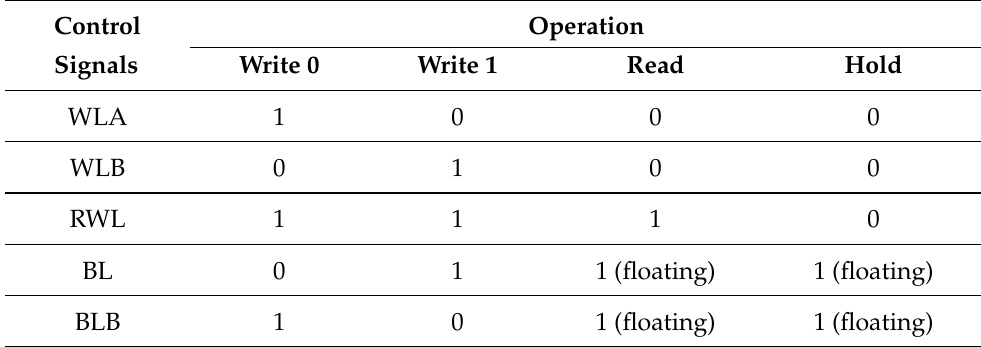
Table 1. Proposed D 2 LP10T cell control